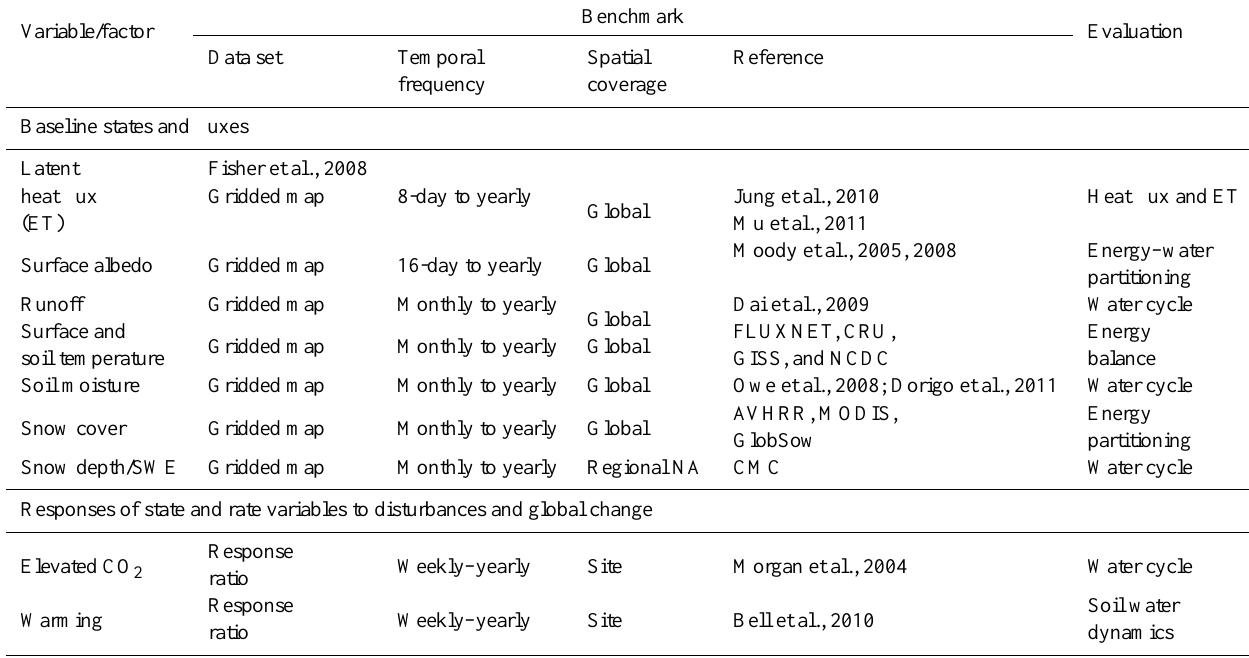
Table 2. Candidate benchmarks to be used to evaluate biophysical